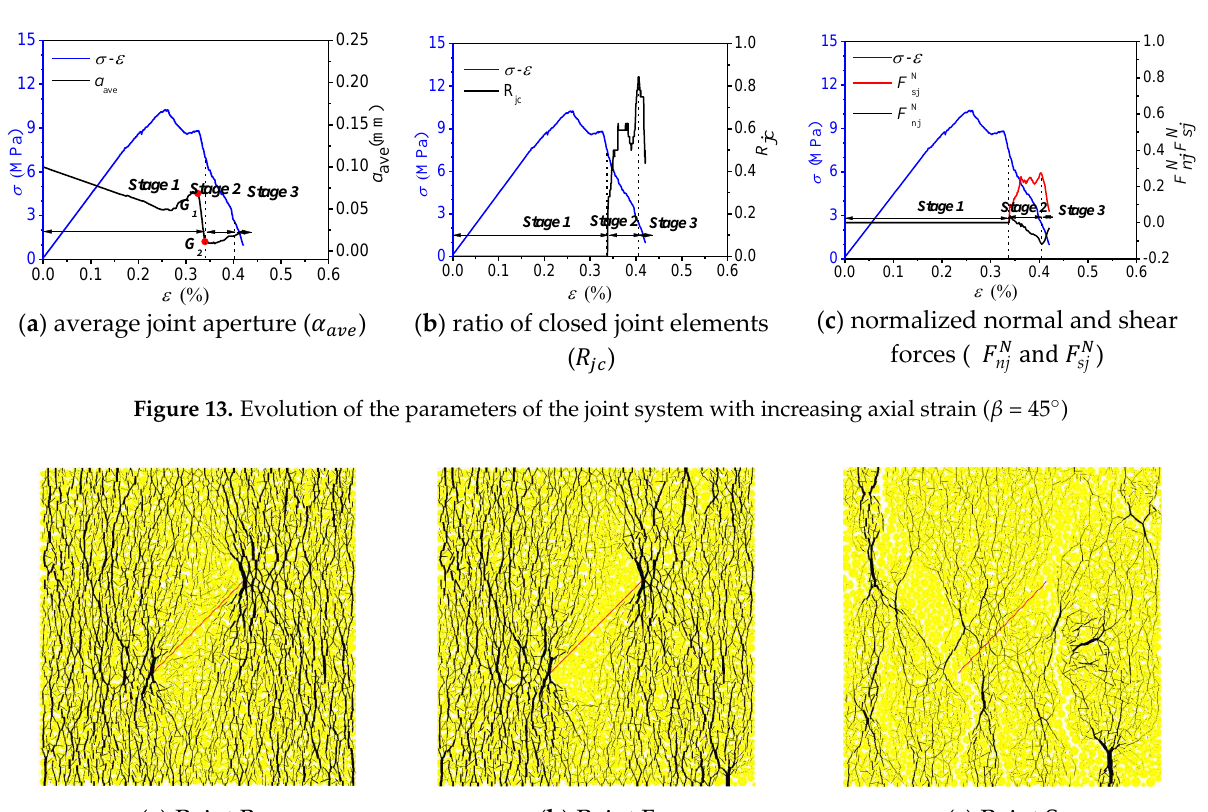
Figure 12. Evolution of force chain distribution with axial strain increases ( 𝛽 =30°).